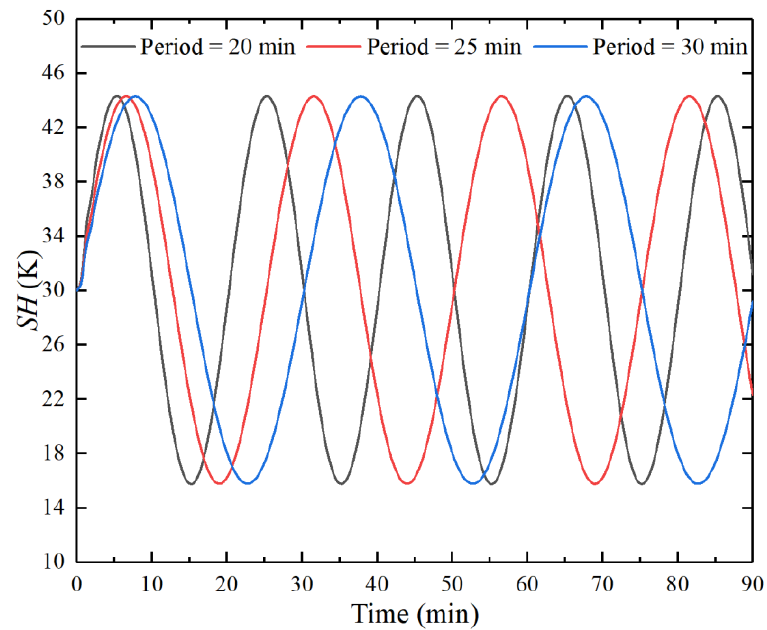
Figure 15. Superheat degree under different periods.